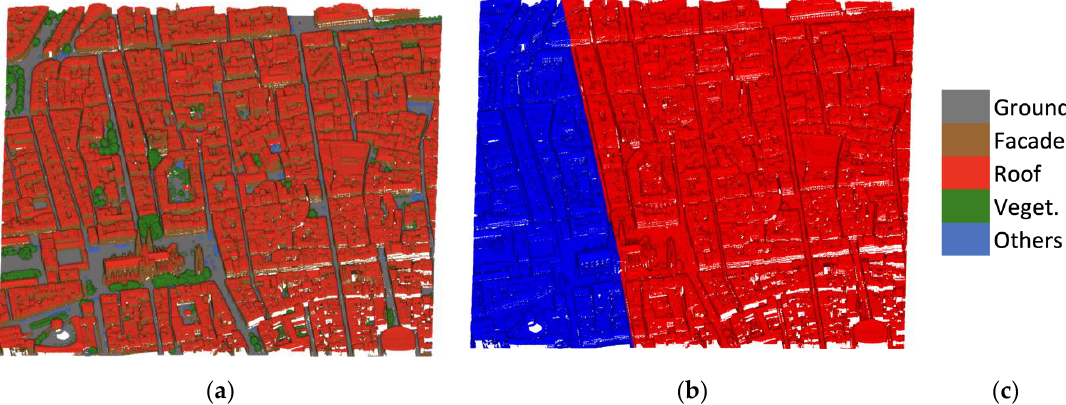
Figure 11. Bordeaux point cloud with its five classes ( a ). The dataset is separated ( b ) into training (~70%, blue) and test (~30%, red). ( c ) Legend.